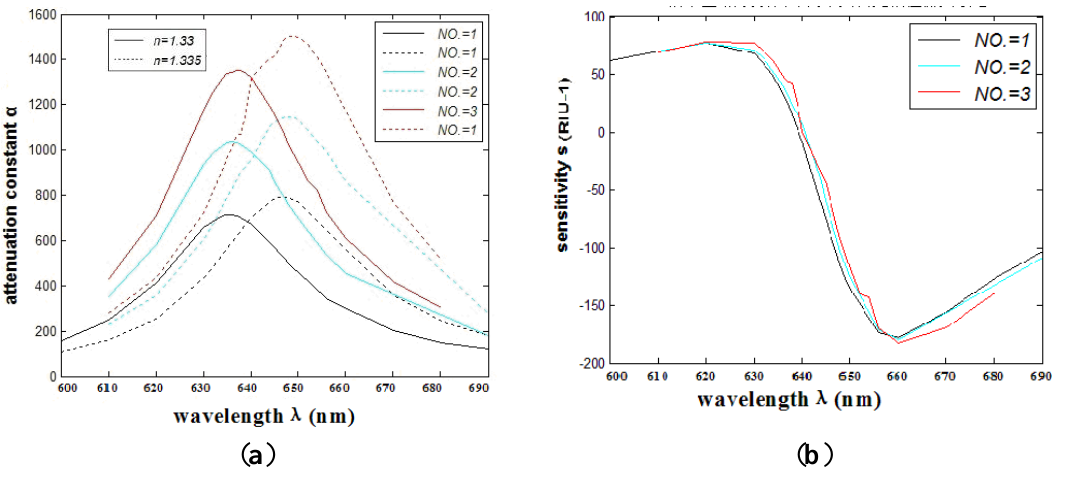
Figure 6. ( a ) The comparison of attenuation constant of the fundamental mode of different numbers ( NO. ) of silver nanowires; ( b ) The comparison of intensity detection sensitivity (RIU −1 ) curves.